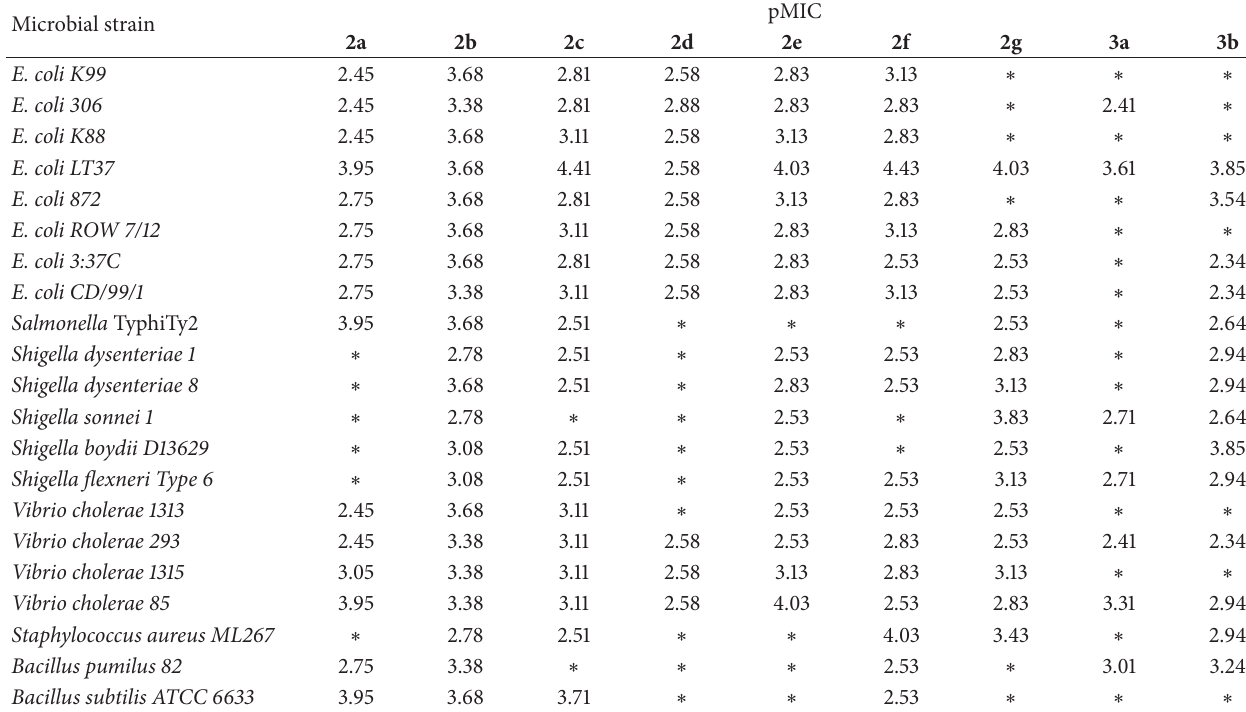
Table 1: Antimicrobial activity of compounds 2a–2g and 3a-3b